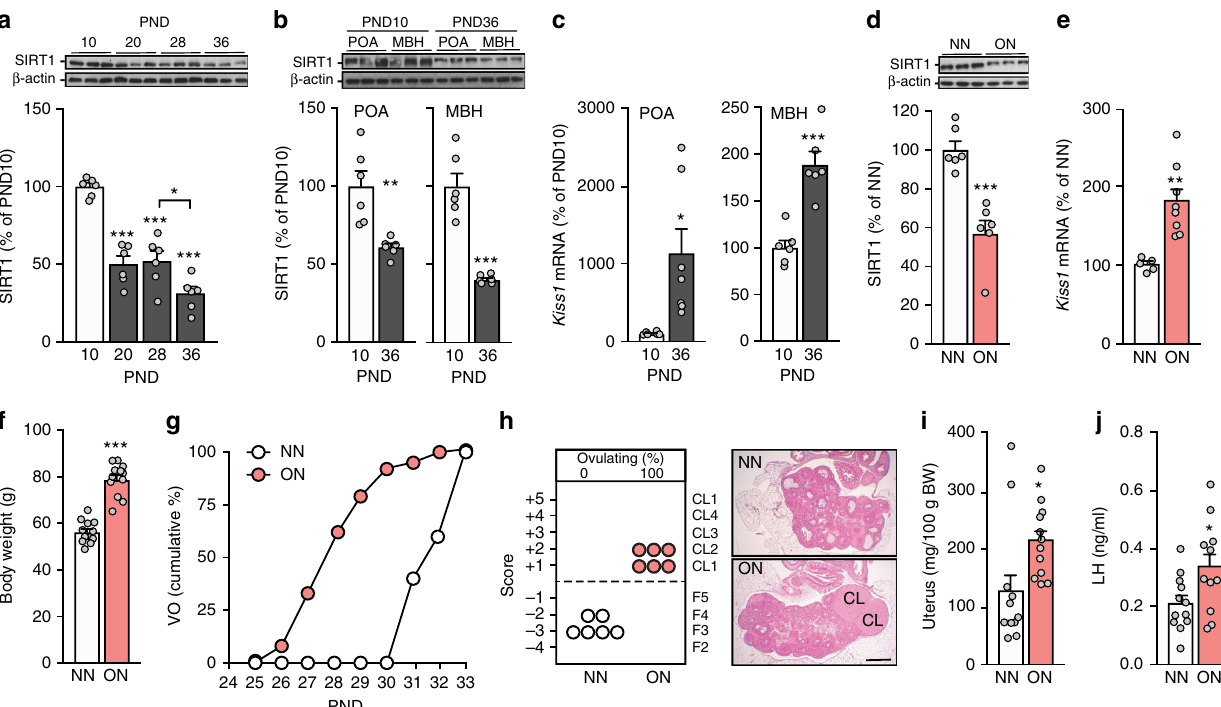
Fig. 1 Changes in hypothalamic SIRT1 content and pubertal timing induced by overnutrition. a SIRT1 content in the medial basal hypothalamus (MBH)/ Preoptic area (POA) of female rats at the infantile (PND10; white bars), early juvenile (PND20; gray bars), late juvenile/pre-pubertal (PND28; gray bars), and peripubertal (PND36; gray bars) stages of reproductive development, determined by western blot analysis. * p < 0.05 vs. PND28; *** p < 0.001 vs. PND10 (one-way ANOVA followed by post-hoc Tukey test). b , c SIRT1 protein and Kiss1 mRNA content in the MBH and POA at PND10 and PND36; for data in a − c , n = 6 animals per group. d , e SIRT1 content and Kiss1 mRNA levels in the MBH of late juvenile, 29-day-old female rats fed normally (NN: normal nutrition; white bars) or subjected to nutritional excess (overnutrition, ON; light red bars) during postnatal development. f Body weight of NN and ON animals. g Cumulative percent of NN and ON animals at vaginal opening (VO). h Histological score of follicular development/ovulation and representative images of ovarian maturation in NN and ON groups; CL: corpus luteum. i Uterine weight in NN and ON animals. j Plasma LH in the same animals. The bar histograms represent the mean ± SEM. In panels b - f , i and j , * p < 0.05; ** p < 0.01; *** p < 0.001 (two-sided Student ’ s t test). For protein analyses in panels a , b and d , three representative bands per group, run in the same original western blots, are presented. The scale bar in panel h corresponds to 600 μ m. Total group sizes were: NN = 11 and ON = 12; while phenotypic and hormonal parameters were assayed in the whole groups, hypothalamic protein/RNA ( d , e ) and ovarian histological ( h ) analyses were conducted in a representative subset of randomly assigned samples from each group, with the following distribution: d , e NN = 5; ON = 6 − 8; h n = 6 in each